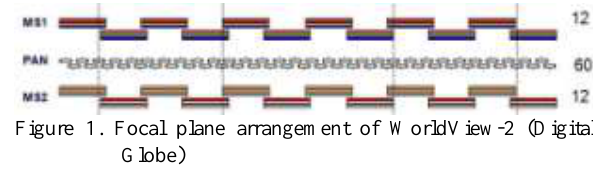
Figure 1. Focal plane arrangement of WorldView-2 (Digital Globe)